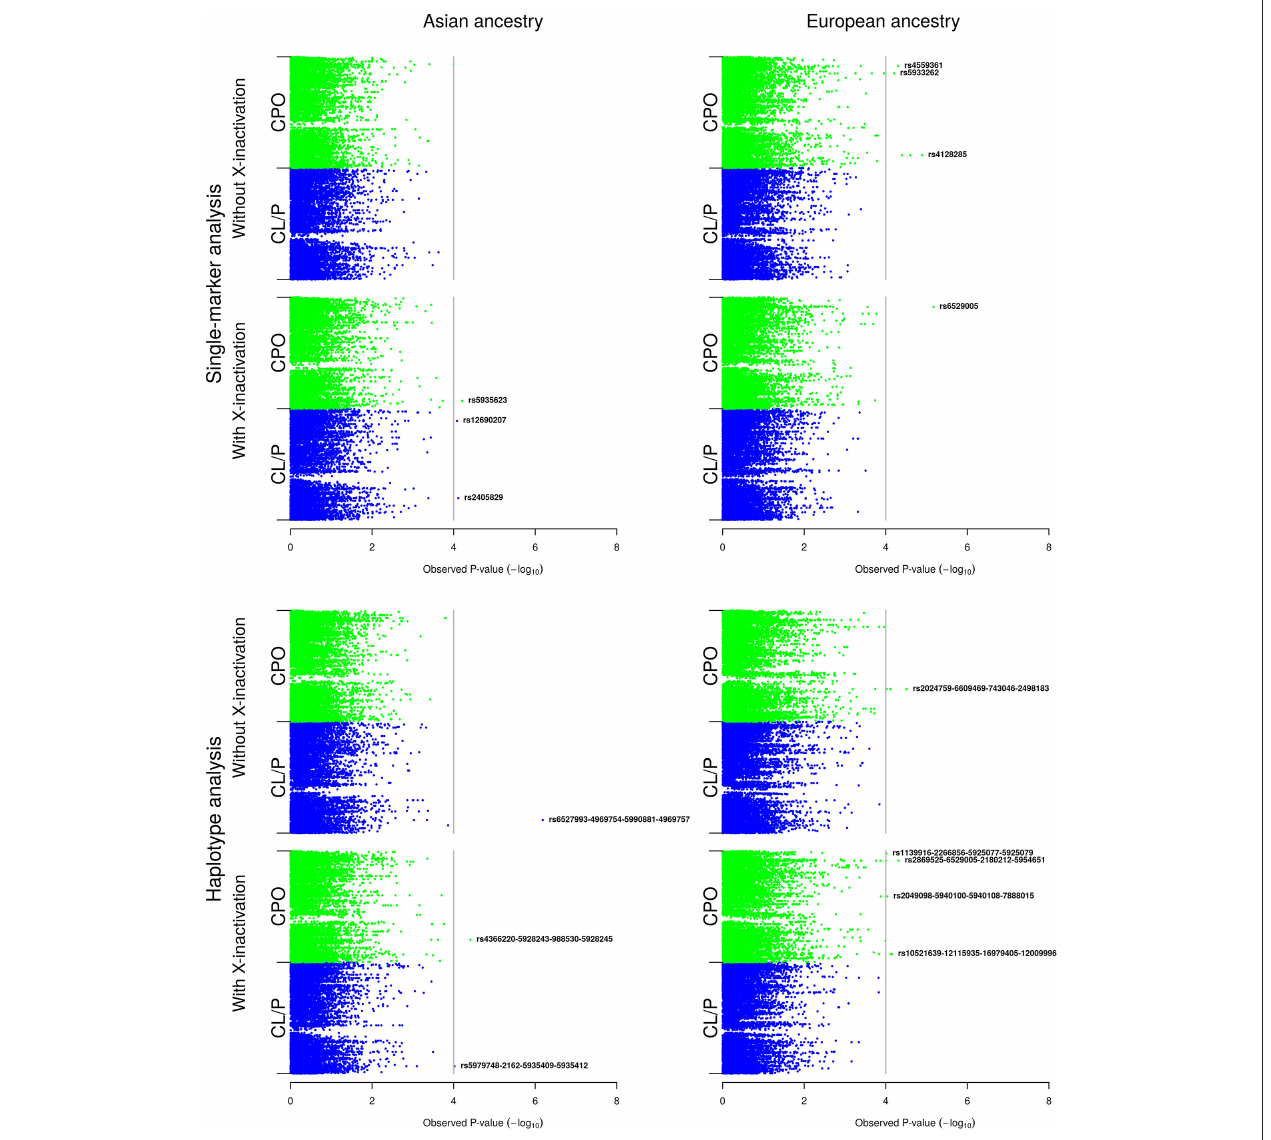
FIGURE 2 | Single-marker and haplotype analyses in the Asian and European samples without stratification by child’s sex. The Manhattan plots show the single-marker and haplotype analyses based on the model without and with X-inactivation in females, respectively. For convenience, we have added a vertical line corresponding to a Bonferroni-corrected p -value cutoff of 10 − 4